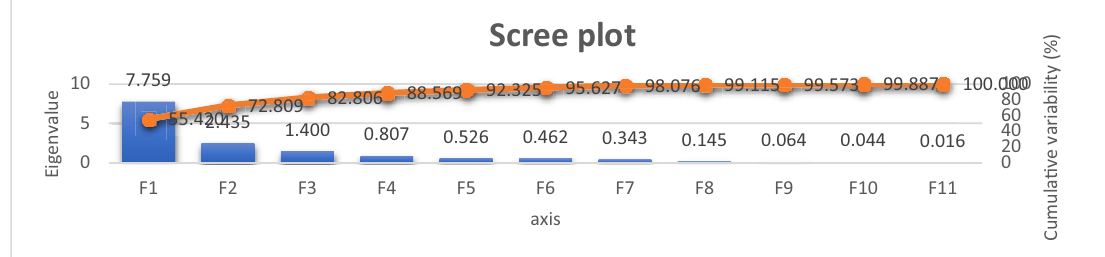
Figure 1: The eigenvalue of the selection criteria for the design consultant.